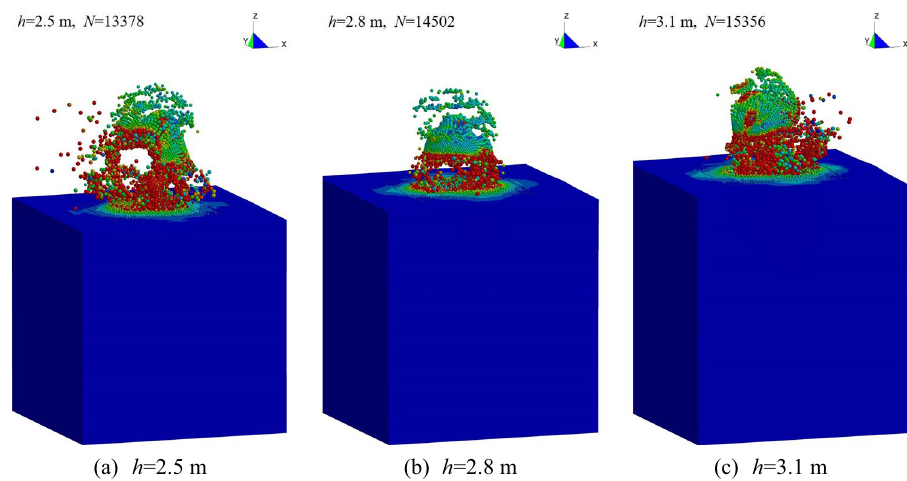
Fig. 17 Different cut hole depths. a h = 2.5 m; b h = 2.8 m; c h = 3.1 m